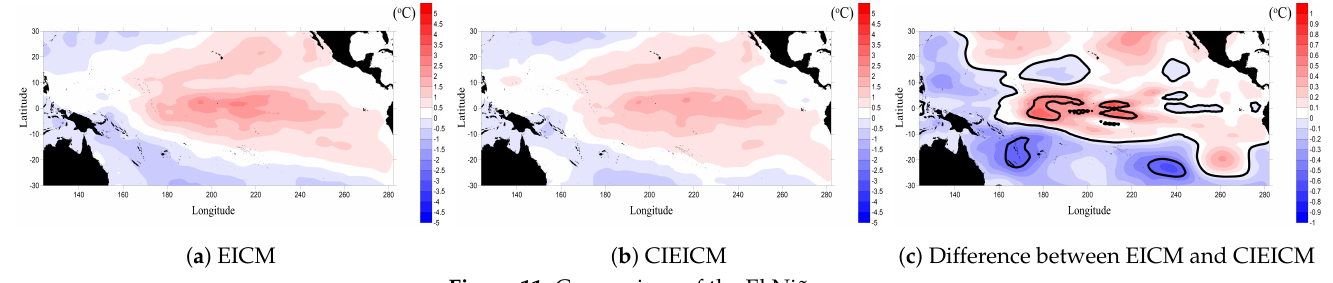
Figure 11. Comparison of the El Niño range.